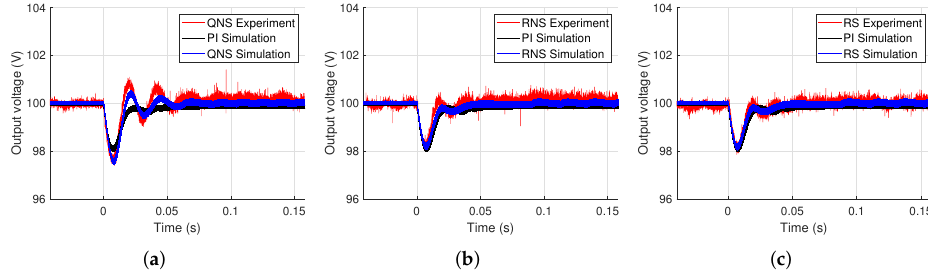
Figure 8. Comparison between min-type and classic controller on a load change. Load changes from 96.8 Ω to 48.4 Ω ( a ) Quadratic Non-Sampled (QNS) Controller, ( b ) Robust Non-Sampled (RNS) Controller, ( c ) Robust Sampled